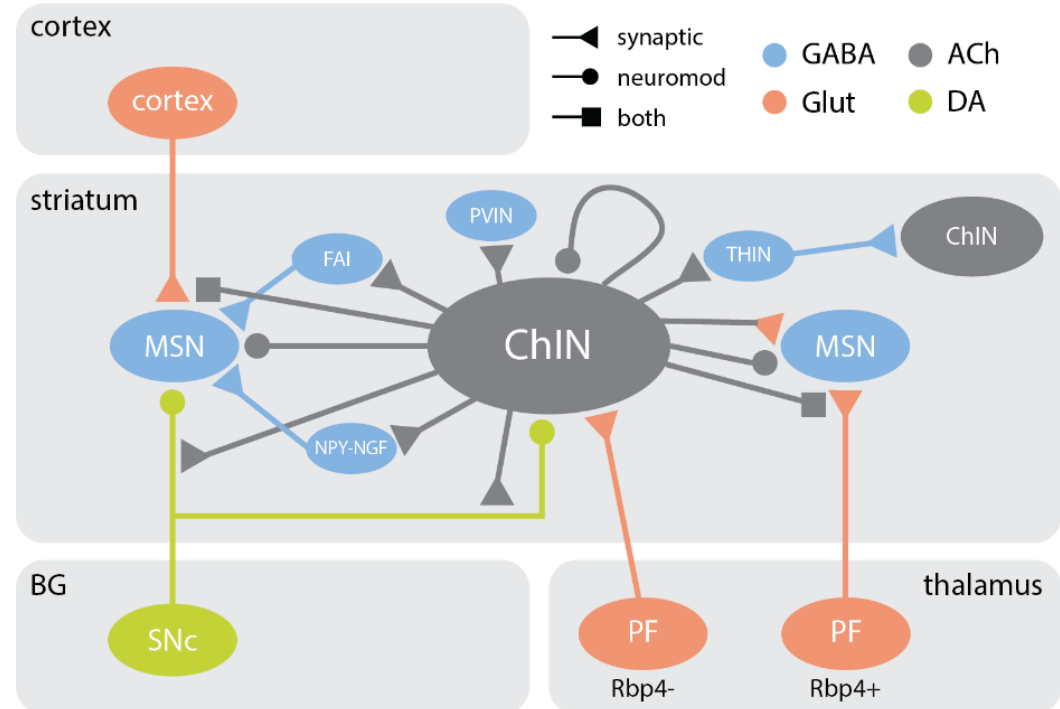
Figure 3. Simplified output map of striatal cholinergic interneurons. Cholinergic interneurons make local connections within the striatum, both conventional synaptic connections that involve nicotinic acetylcholine (ACh) receptors, and volume transmission sites that involve muscarinic ACh receptor signaling. At corticostriatal and thalamostriatal terminals onto MSNs, both nicotinic and muscarinic ACh transmission occur. Abbreviations: MSN = medium spiny neuron, SNc = substantia nigra pars compacta, FAI = fast-adapting interneuron, NPY-NGF = neuropeptide Y-expressing neurogliaform interneuron, PVIN = parvalbumin-expressing interneuron, ChIN = cholinergic interneuron, PF = parafascicular thalamic neuron, THIN = tyrosine hydroxylase-expressing interneuron .